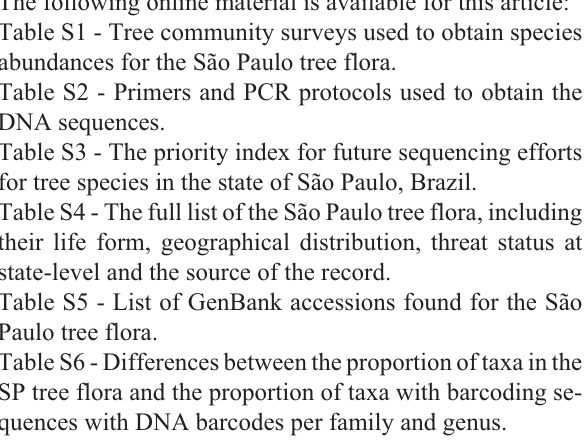
Table S2 - Primers and PCR protocols used to obtain the DNA sequences. Table S3 - The priority index for future sequencing efforts for tree species in the state of São Paulo, Brazil. Table S4 - The full list of the São Paulo tree flora, including their life form, geographical distribution, threat status at state-level and the source of the record. Table S5 - List of GenBank accessions found for the São Paulo tree flora. Table S6 - Differences between the proportion of taxa in the SP tree flora and the proportion of taxa with barcoding se- quences with DNA barcodes per family and